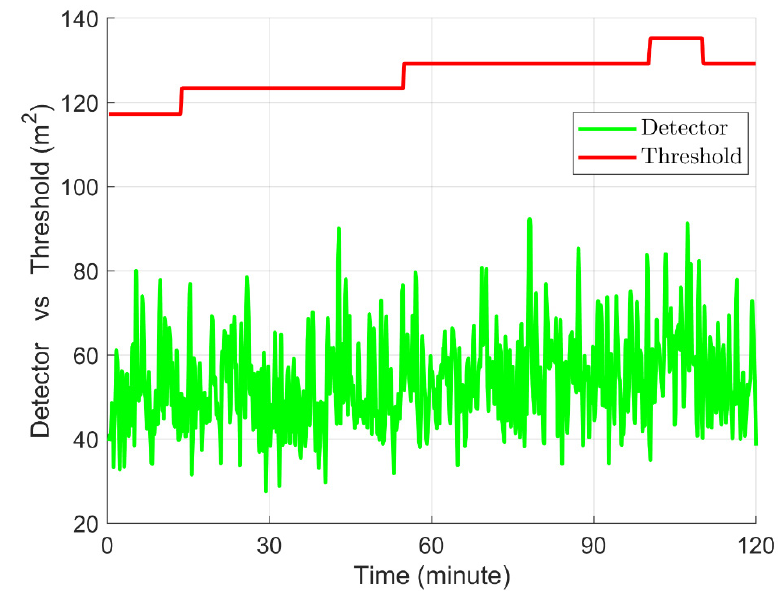
Figure 6. Time series of the fault detector and threshold.